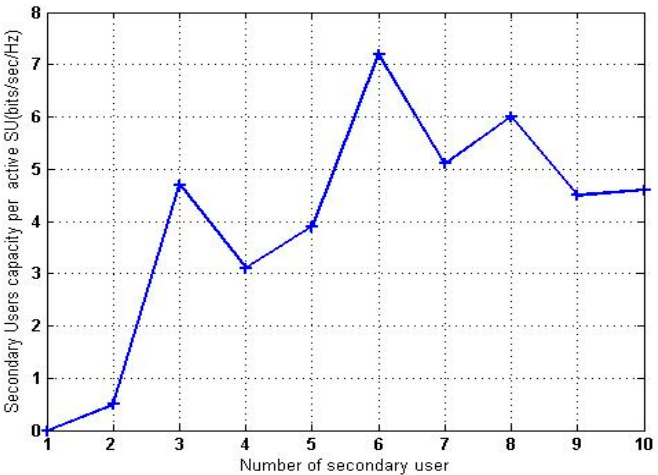
Figure 3. Active SU.